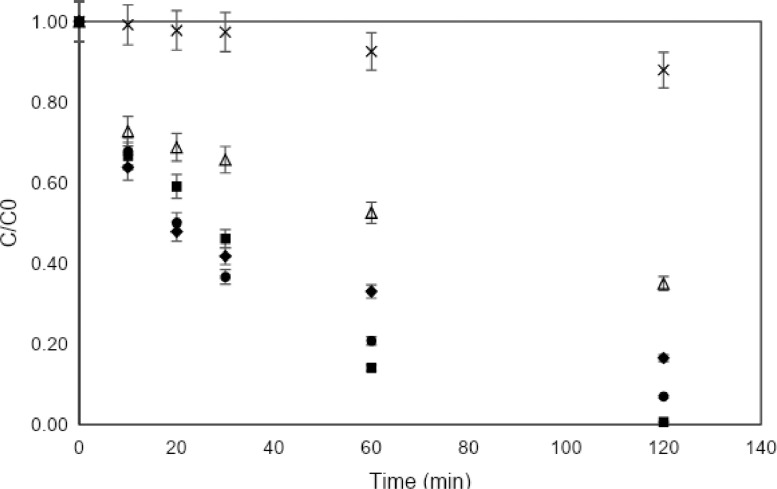
Discoloration of MB under solar simulator at lab test [MB] = 30 ppm, [catalyst]=0.3 g/L.(●) TiO2/Fe3O4 (80/20), (♦) TiO2/Fe3O4 (50/50), (∆) TiO2/Fe3O4 (20/80), (×) Fe3O4.